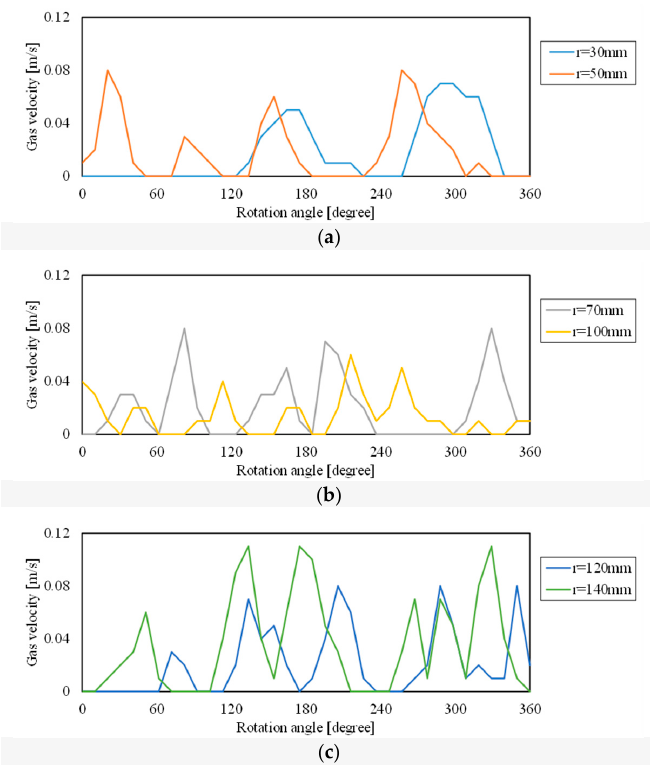
Figure 4. Circumferential gas velocity distribution measured by experimental apparatus: ( a ) r = 30 mm, 50 mm; ( b ) r = 70 mm, 100 mm and ( c ) r = 120 mm, 140 mm.